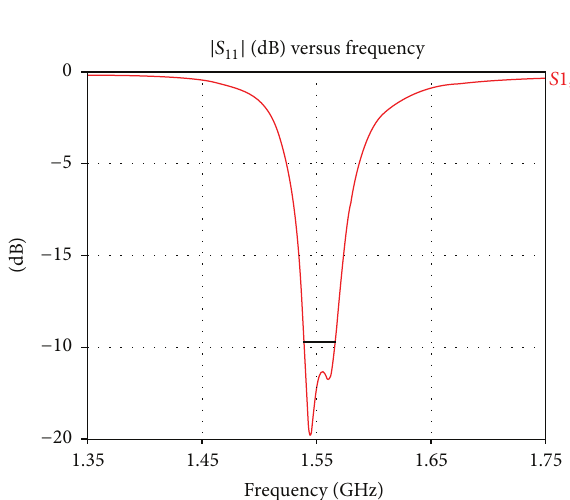
Figure 6: Single element return loss versus